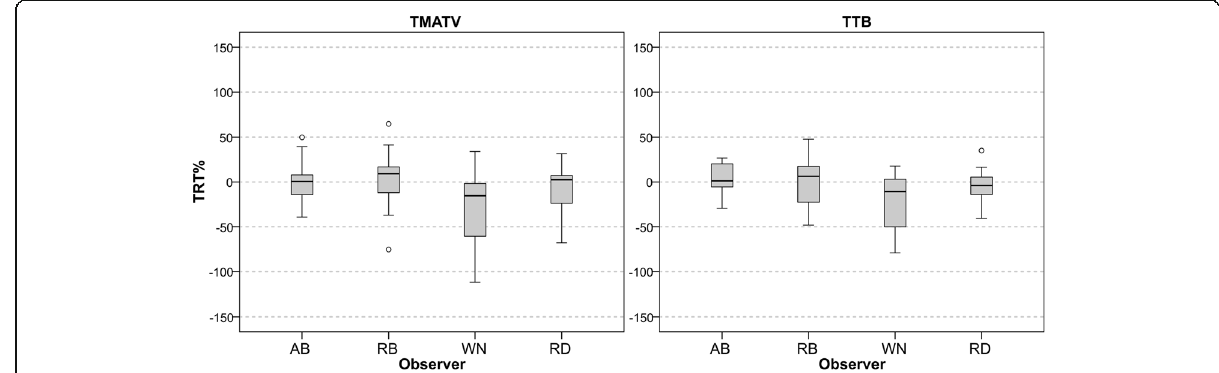
Fig. 4 Box plots of TMATV (left panel) and TTB (right panel) repeatability from the three experienced observers and their consensus, RD